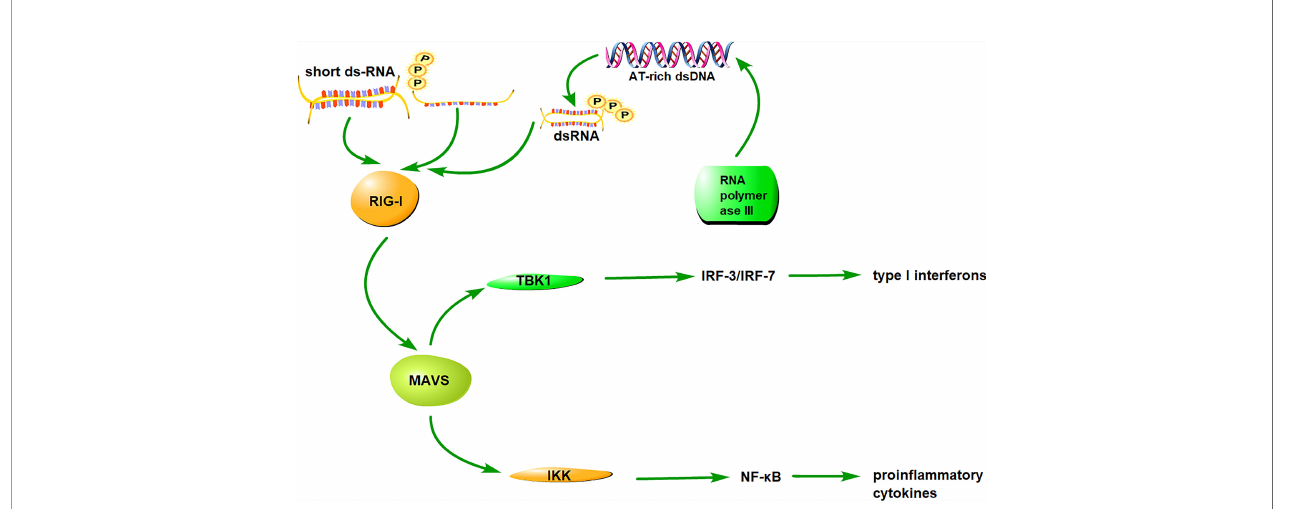
FIGURE 1 | The signaling pathway of RIG-I. RIG-I distinguishes and binds to RNA/DNA via the CTD, subsequently exposing CARDs and catalyzing ATP hydrolysis. RIG-I interacts with its downstream adaptor molecule, MAVS, and activates two cytosolic protein kinase complexes, TBK1 and IKK. The TBK1 complex phosphorylates IRF-3/7 and induces type I interferon production, whereas the IKK complex activates NF- k B and promotes the production of proin fl ammatory cytokines.